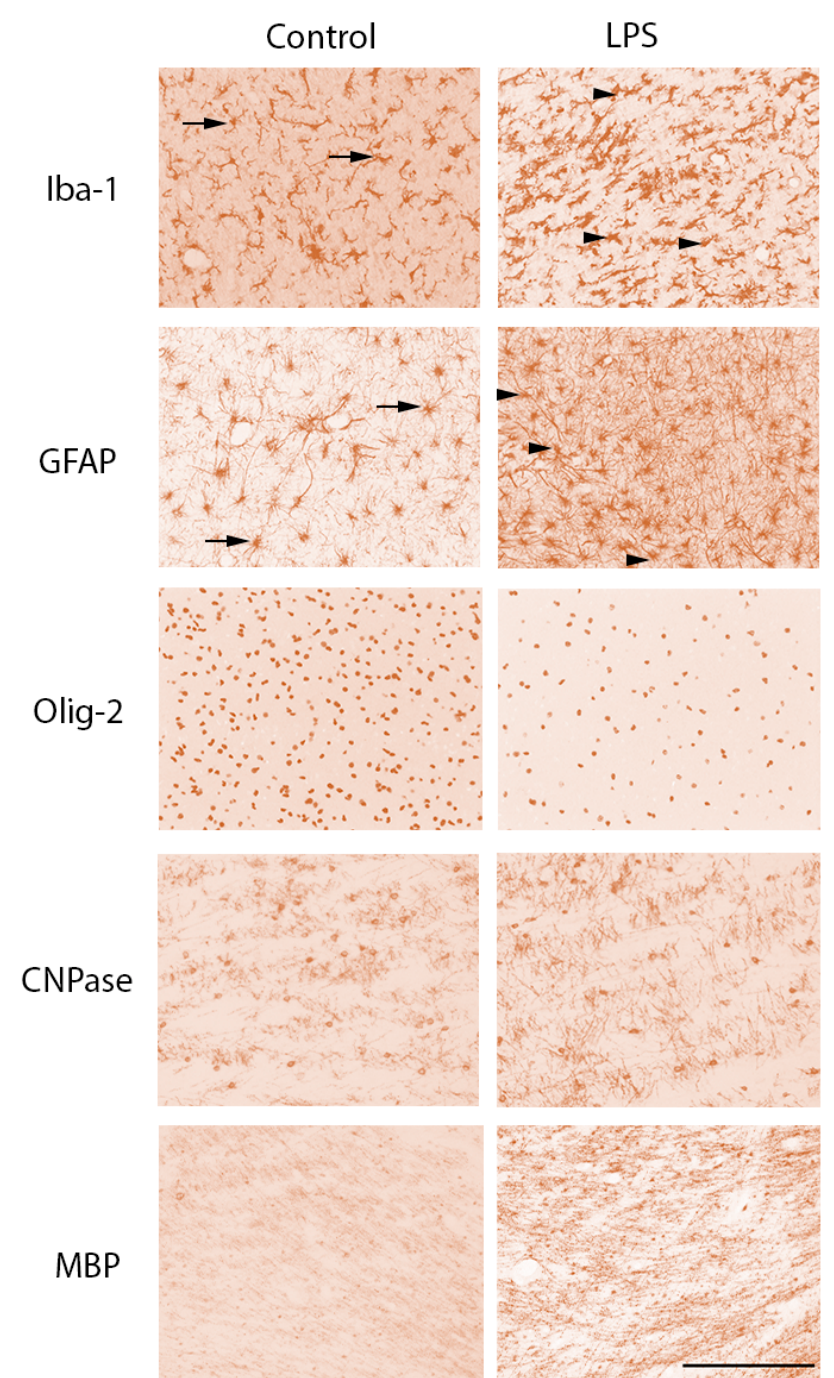
Figure 3. Photomicrographs of white matter tracts. Representative photomicrographs showing Iba-1-, glial fibrillary acidic protein (GFAP)-, Olig-2-, CNPase-, and MBP-positive staining in the periventricular white matter tracts. LPS, lipopolysaccharide. Scale bar is 200 µ m. Arrows in the Iba-1 photomicrographs indicate microglia displaying a resting ramified phenotype, characterized by a small cell body with > 1 branching process. Arrowheads in the Iba-1 photomicrographs from the LPS group indicate microglia displaying an amoeboid morphology, characterized by a large cell body with ≤ 1 branching process. Arrows in the GFAP photomicrographs indicate astrocytes with an isotropic appearance. Arrowheads in the GFAP photomicrographs from the LPS group indicate astrocytes displaying greater coherence and more anisotropy compared to